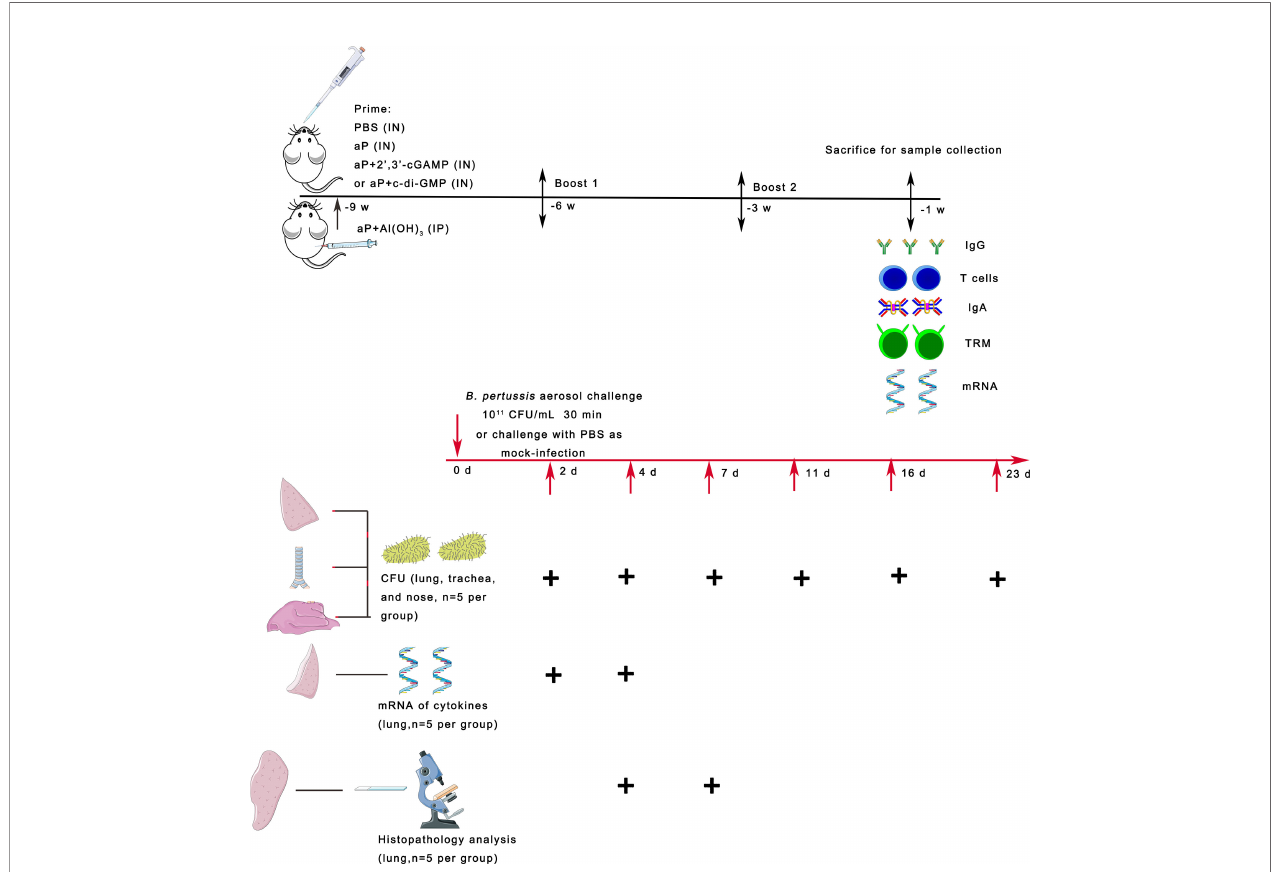
FIGURE 1 | Scheme of mouse immunization and B. pertussis challenge. BALB/c mice were immunized with three doses of the different vaccines via the intranasal (IN) or intraperitoneal (IP) route at 3-week intervals. Control mice received PBS via the IN route. To evaluate speci fi c immune responses, including systemic and mucosal immune responses, mice were bled and sacri fi ced two weeks after the last immunization for sample collection. Three weeks after the last immunization, the mice were infected with B. pertussis by aerosol challenge. In parallel, naïve mice were challenged with PBS as a mock-infection group. On days 2, 4, 7, 11, 16, and 23 after B. pertussis infection (dpi), lungs, trachea, and nasal mucosa were collected from each group of mice, and the numbers of B. pertussis CFU in the upper and lower respiratory tracts were determined by dilution plating. On days 2 and 4 after infection, the mRNA expression levels of the indicated cytokines were determined by real-time quantitative PCR (RT – qPCR) in the lung tissues. On days 4 and 7 after infection, lung tissues were collected, processed into paraf fi n sections and stained with